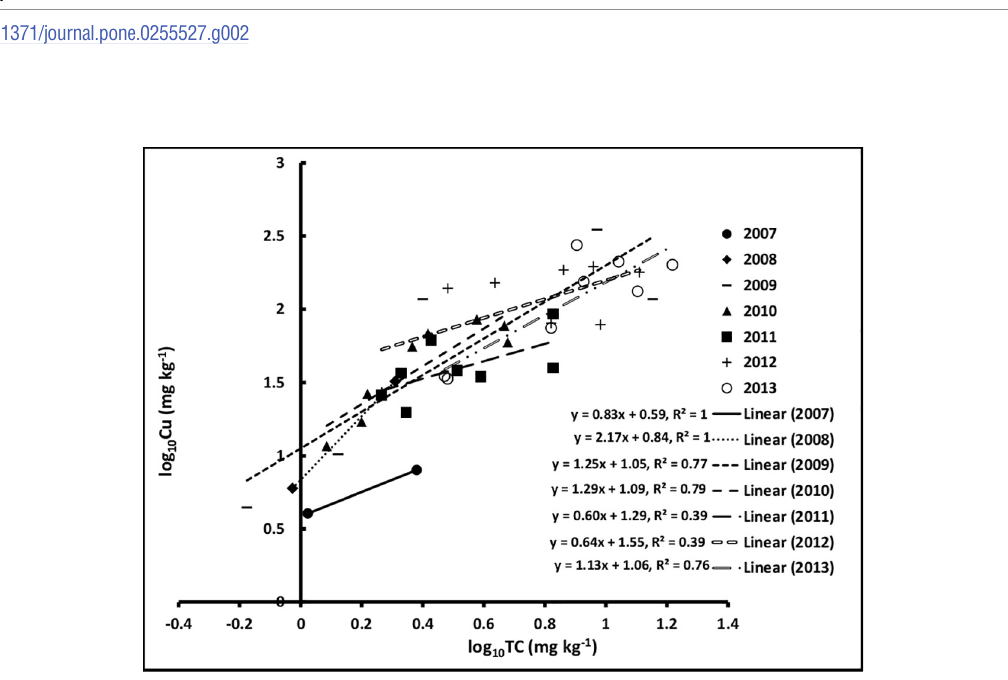
PLOS ONE | https://doi.org/10.1371/journal.pone.0255527 August 3,